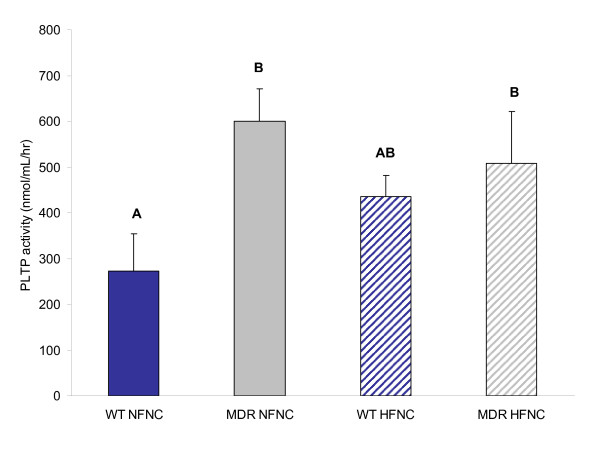
Plasma phospholipid transfer protein (PLTP) activity in P-glycoprotein deficient mice (Mdr1a/-/-/1b-/-) fed normal and high fat diets. A significant increase in PLTP activity was associated with the P-glycoprotein deficient genotype (n = 5; p < 0.05). Differing letter designations indicate statistically significant data.